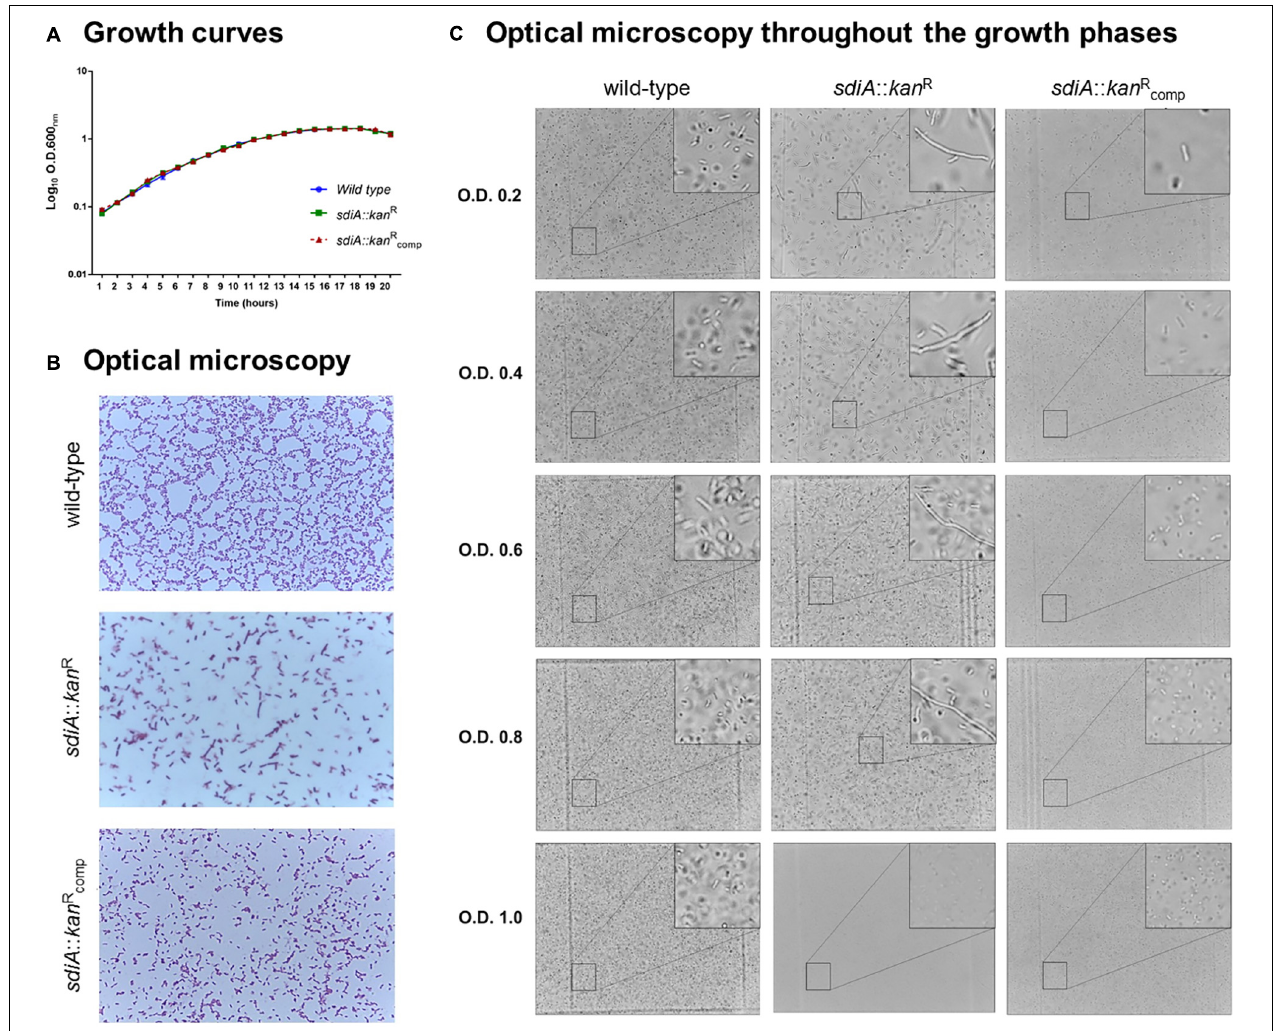
FIGURE 1 | Lack of SdiA affects cell division and leads to morphological alterations of K. pneumoniae cells. (A) Growth curves of the wild-type, mutant ( sdiA :: kan R ) and complemented ( sdiA :: kan R comp ) strains are displayed as log scale of the optical density of the cultures of each strain measured at the indicated times. No differences in growth curves were observed among the strains. (B,C) Aliquots of the cultures of each strain were submitted to optical microscopy analyses to investigate the morphology of the bacterial cells. Disruption of sdiA led the mutant strain to exhibit a filamentous phenotype. The mutant strain recover the same morphology of the wild-type and complemented strains only at high cell densities (O.D. 600 nm of